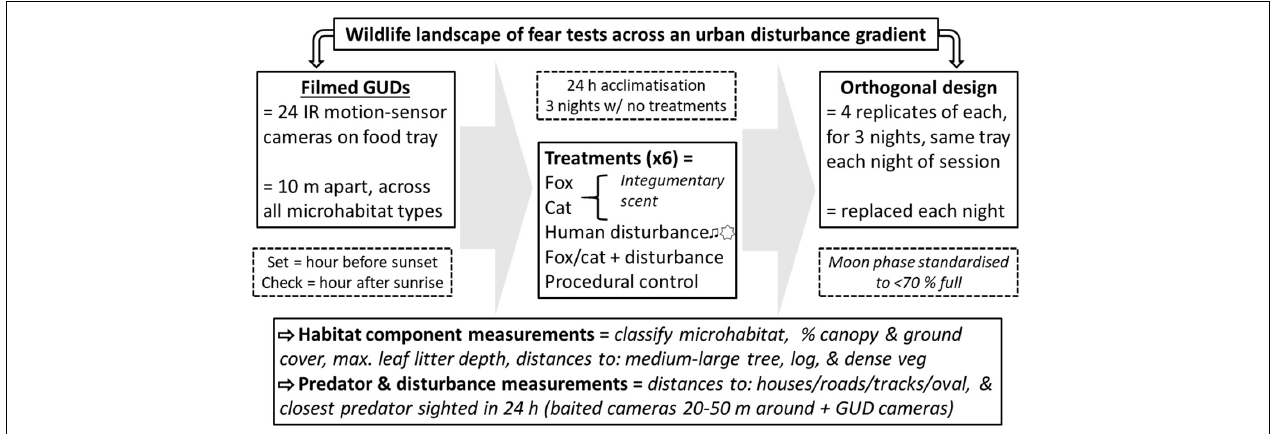
FIGURE 2 | Summary of the survey methods employed to observe small prey animal landscapes of fear across an urban disturbance gradient, relative to habitat component use and distances to the stressors of predators and human disturbances. Measurements and filmed giving-up density (GUD) trials were conducted across three locations (“close environment,” “mid environment,” and “far environment”) along an urban disturbance gradient for three nights of pre-treatment conditions and three nights of treatment conditions replicated across four survey sessions in 1 year ( n = 288 per GUD trial). Treatments included: red fox scent, domestic cat scent, 12 h of continual sound and light as cues for human disturbance, red fox with human disturbance cues, domestic cat with human disturbance cues, and a procedural